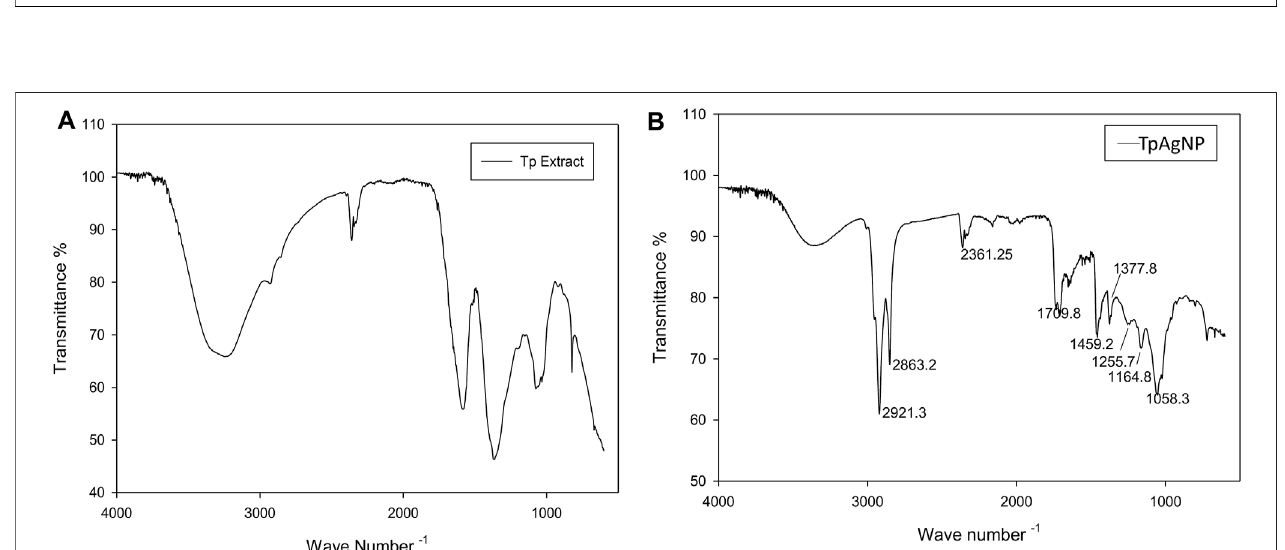
FIGURE 3 | FTIR spectral analyses of (A) plant extract and (B) synthesized TpAgNPs of T. pallida .